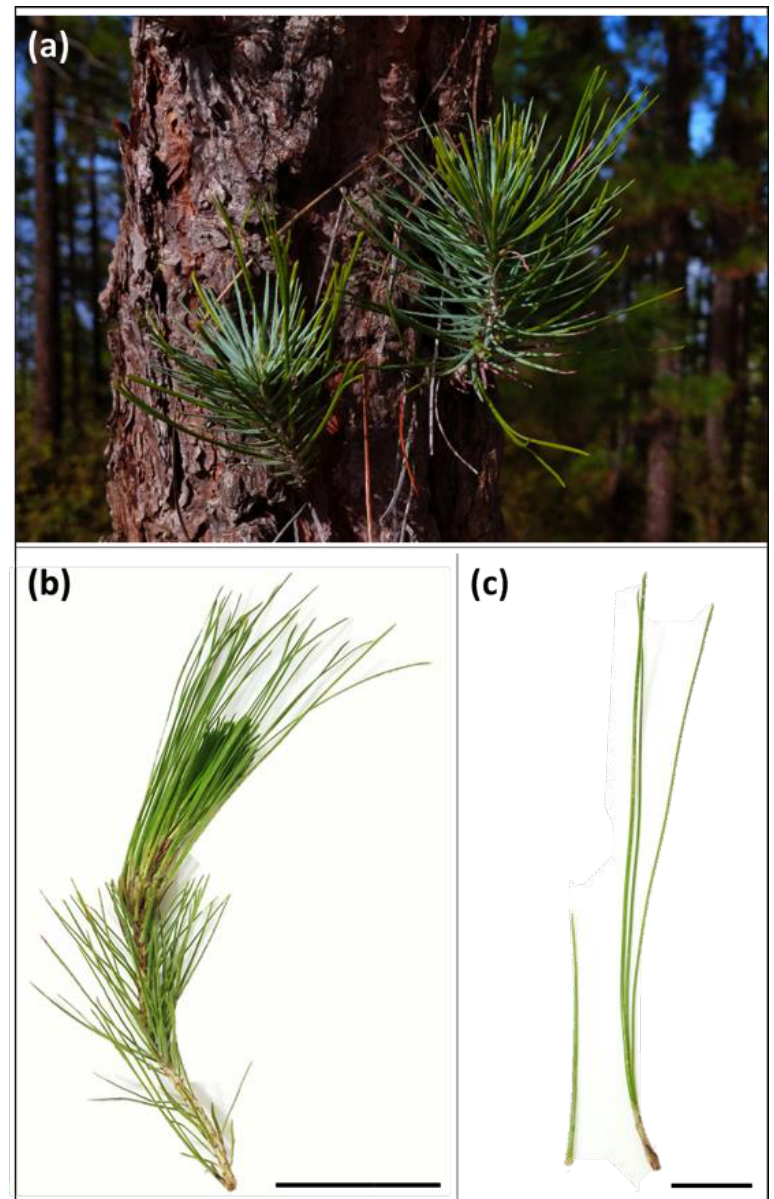
Figure 1. General aspect of the studied needles: ( a ) Intact resprouting twigs; ( b ) Detail of a detached twig with primary needles in the base and secondary needles in the tip. ( c ) Detail of a detached primary needle ( left ) and a brachyblast containing three secondary needles ( right ). Scale bars are: ( b ) 5 cm; ( c ) 2 cm.